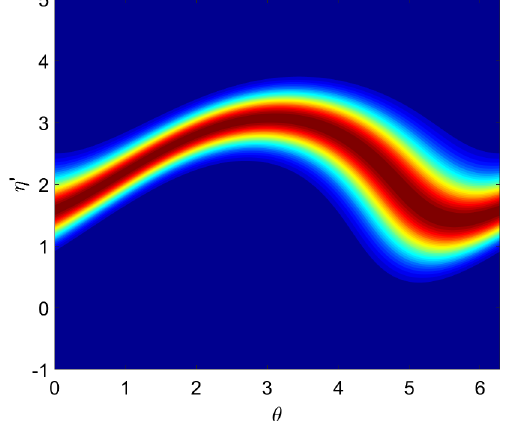
FIG. 1. The complex reflectivity of Bragg crystal at various incident photon energy deviation from Bragg energy.